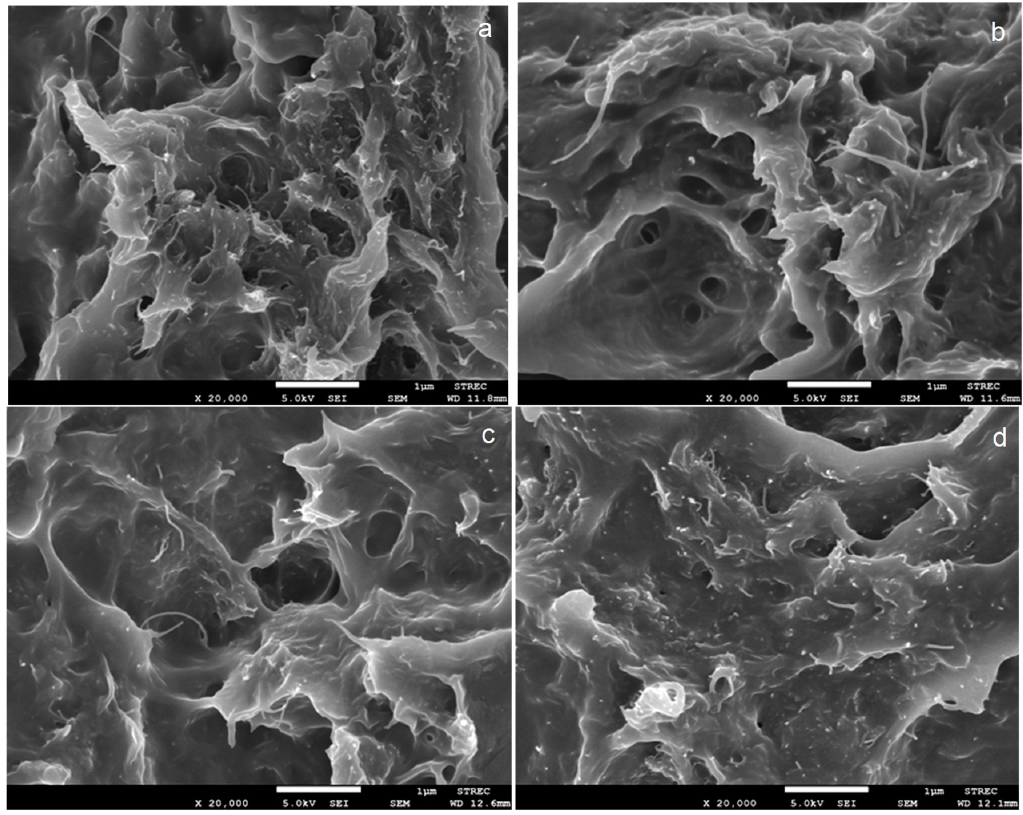
Figure 5 . FESEM images of PU - Ester / MWCNT nanocomposites unannealed ( a ) and annealed at 80 °C Figure 5. FESEM images of PU-Ester/MWCNT nanocomposites unannealed ( a ) and annealed at ( b ) , 100 °C ( c ) and 120 °C ( d ) for 6 h . 80 ◦ C ( b ), 100 ◦ C ( c ) and 120 ◦ C ( d ) for 6